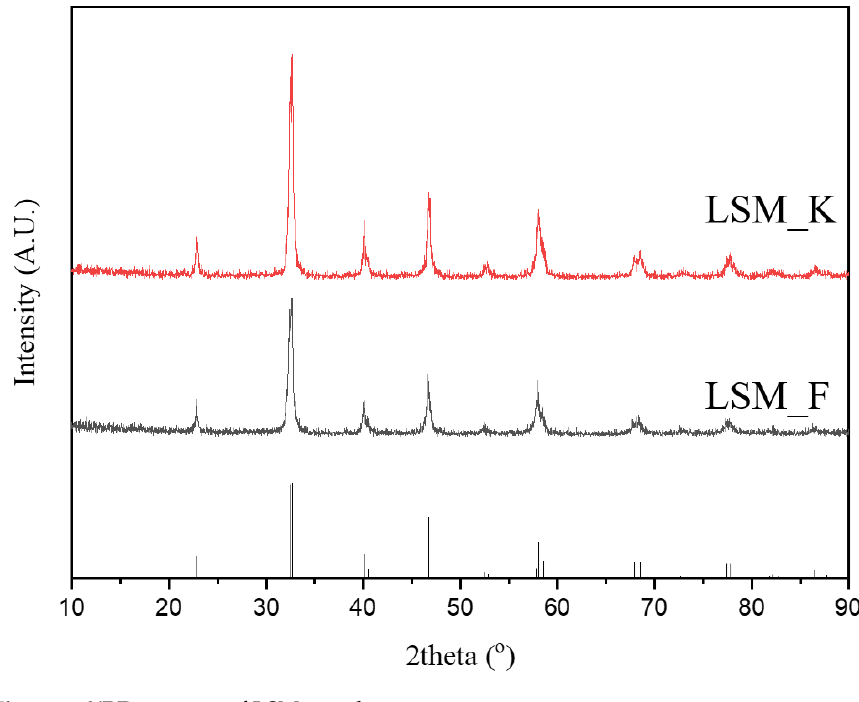
Figure 3. XRD patterns of LSM powders.